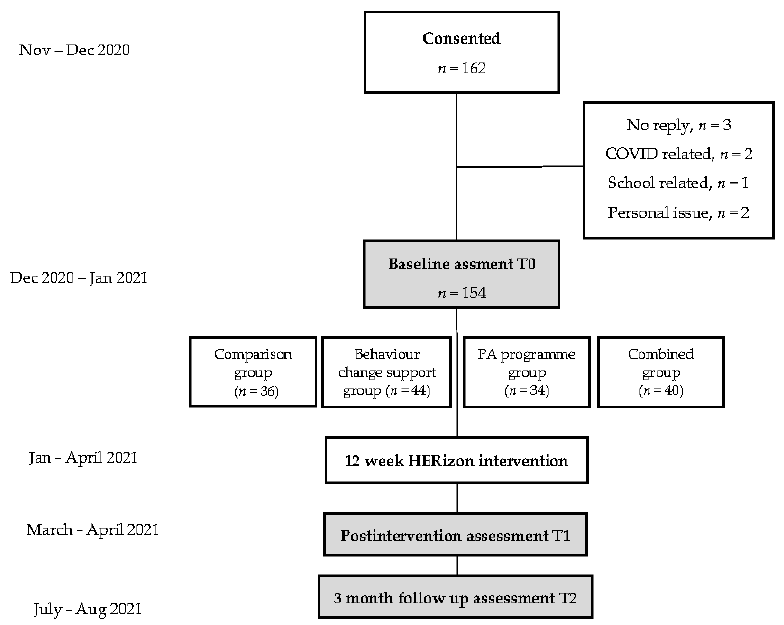
Figure 1. Overview of the HERizon study design.